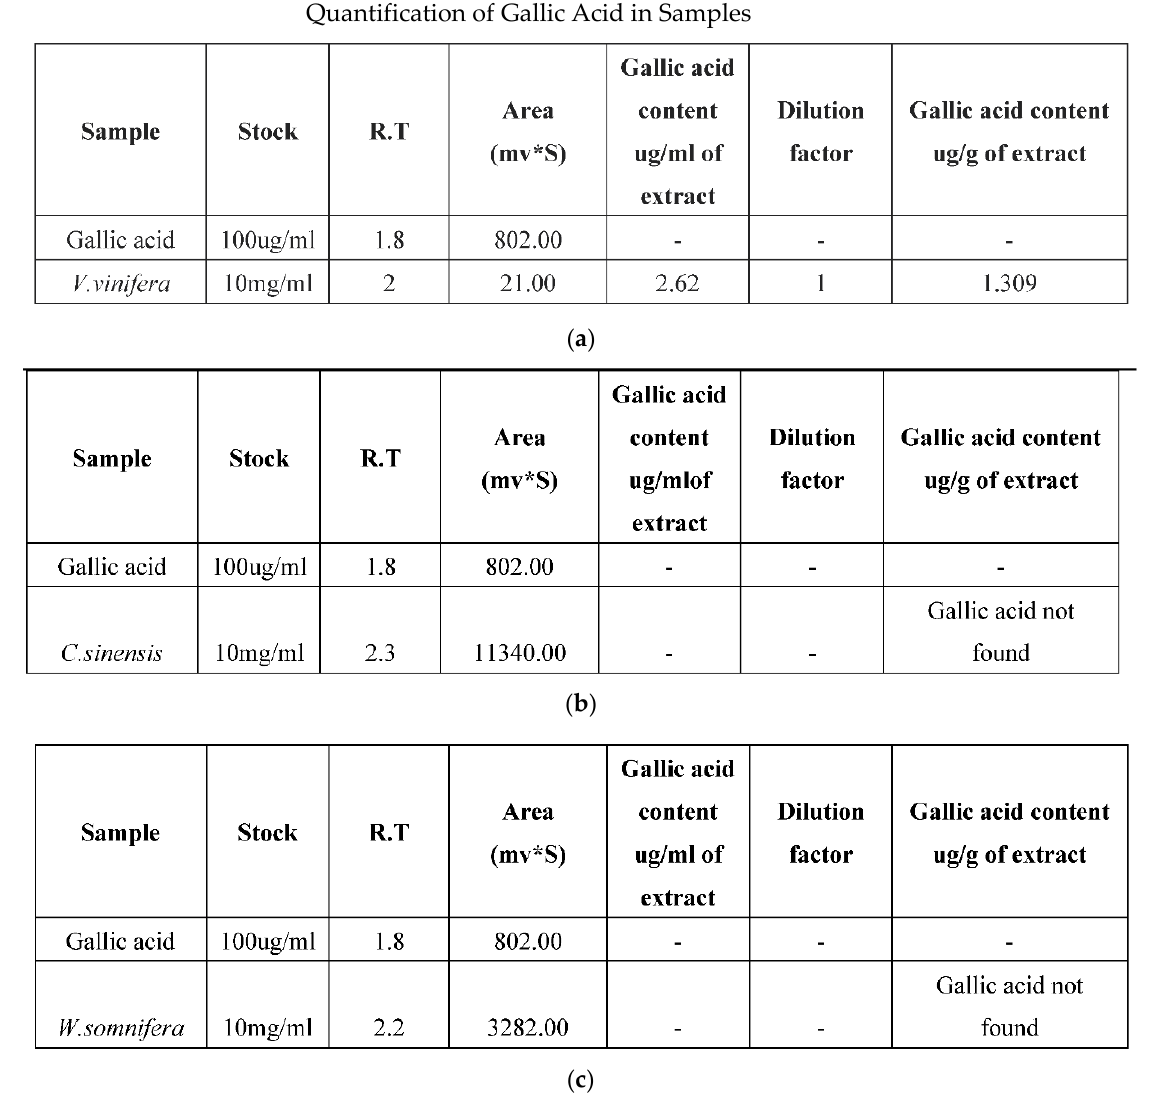
Figure 4. ( a ) Quantification of standard and V. vinifera. ( b ) Quantification of standard and C. sinensis . ( c ) Quantification of standard and W. somnifera .